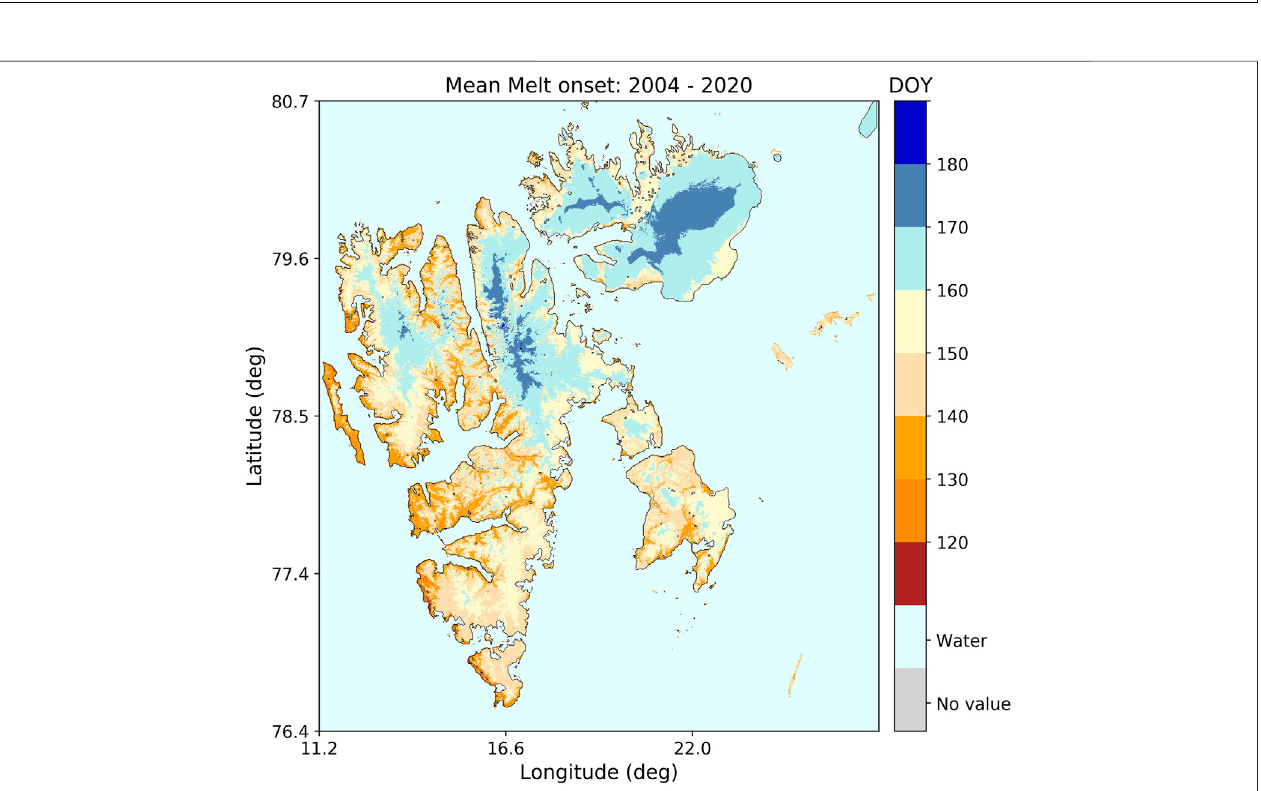
Frontiers in Earth Science |